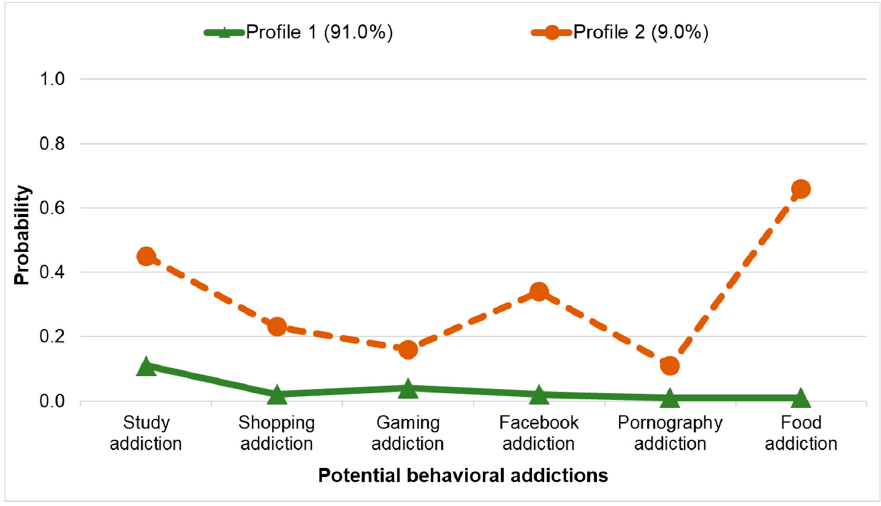
Figure 2. Two-Class LCA Model in the Full Sample. N = 1157. Table 7. Potential Predictors and Outcomes of LPA Membership: Comparison of Classes. Sociodemographics and